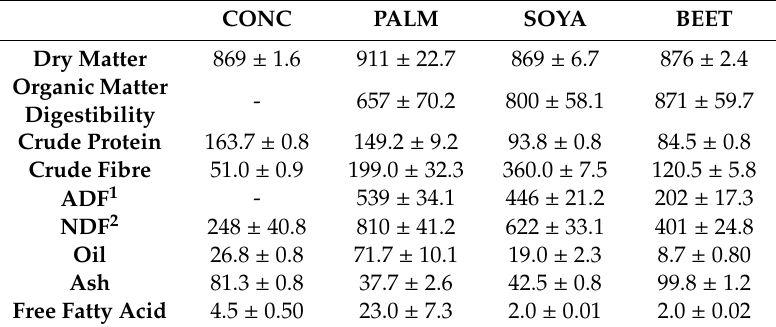
Table 3. Chemical composition (g / kg of DM; mean ± SD) of the supplemented feed collected weekly throughout the experimental period.